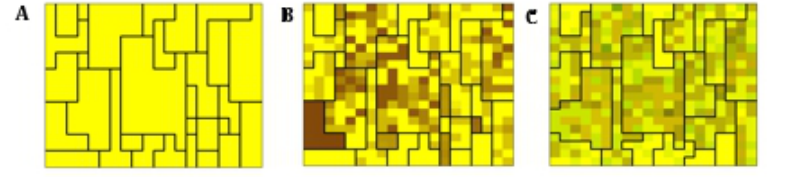
Fig. 2. Land use for a typical model run ( D Prec = 0; D EI = 0.25; Tiered Environmental Licensing). Green indicates forest, yellow pasture, and brown degraded pasture. A) Time = 1 year; B) Time = 10 years; C) Time = 30 years. Note that land owned by a failing ranch at year 10 (brown L-shape in B) has been bought out by neighboring farms by year